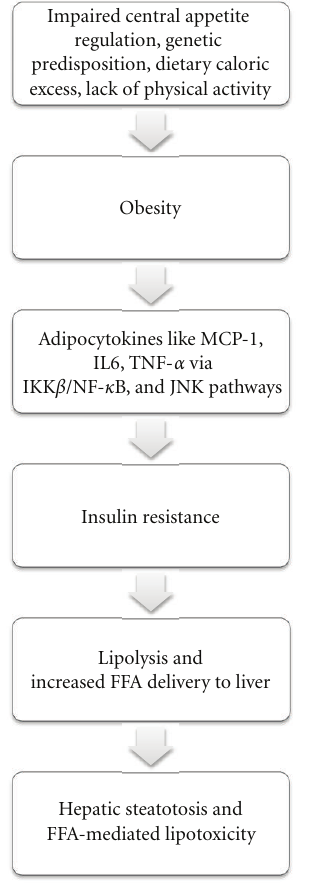
Figure 3: Development and progression of nonalcoholic fatty liver disease. Abbreviations: tumor necrosis factor- α (TNF- α ), interleukin-6 (IL-6), monocyte chemoattractant protein-1 (MCP- 1), I-kappa-B-kinase- β (IKK β ), nuclear-factor-kappa-B (NF- κ B), Jun N-terminal kinase (JNK), and free fatty acids